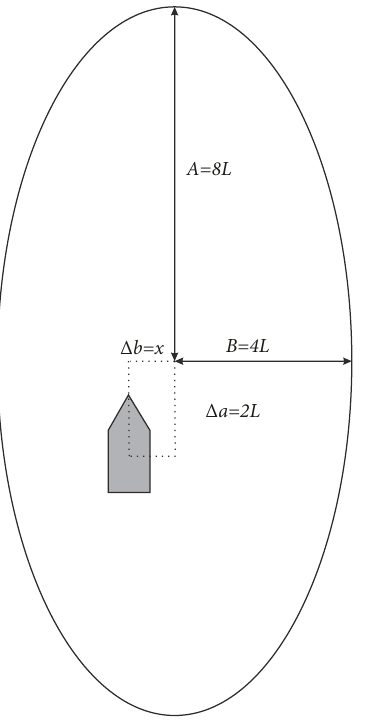
Figure 10: Length-dependent ship’s domains applied in the simula- tions: 𝑥 = 𝐿 for stand-on crossing encounter and 𝑥 = 0 for being overtaken.